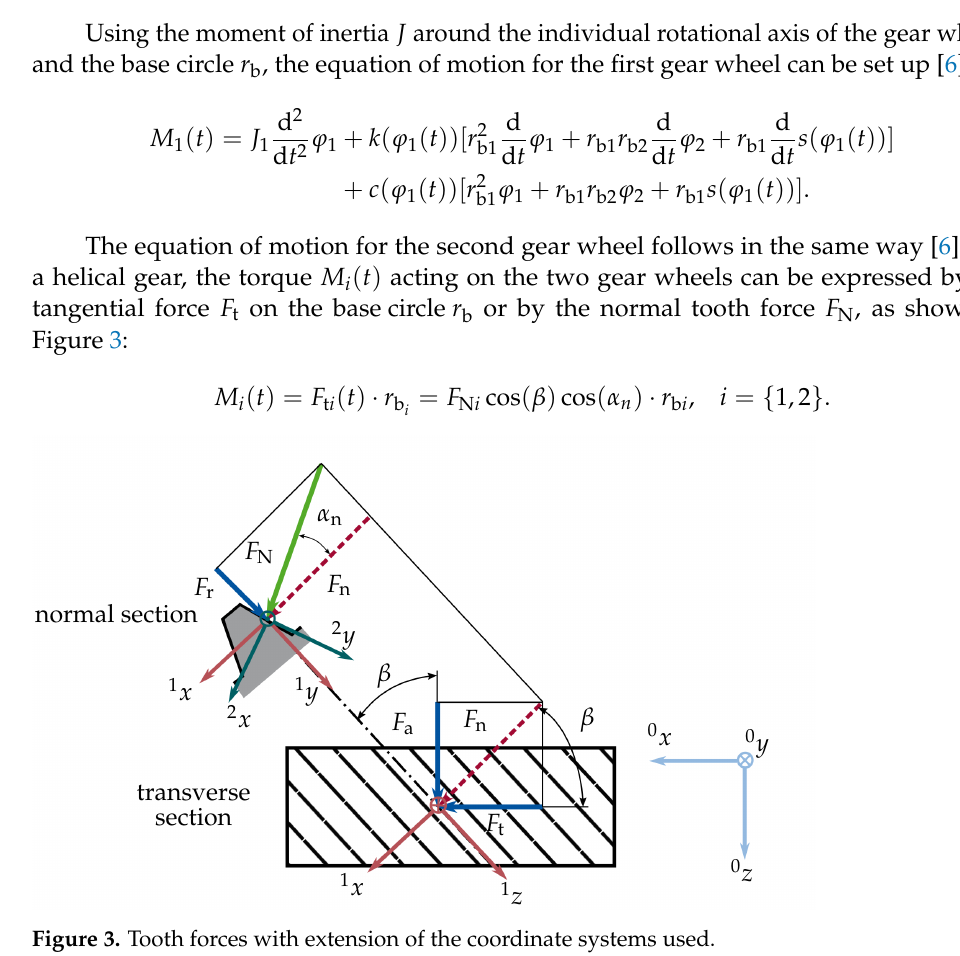
Figure 2. Torsional vibration model with two degrees of freedom [6].